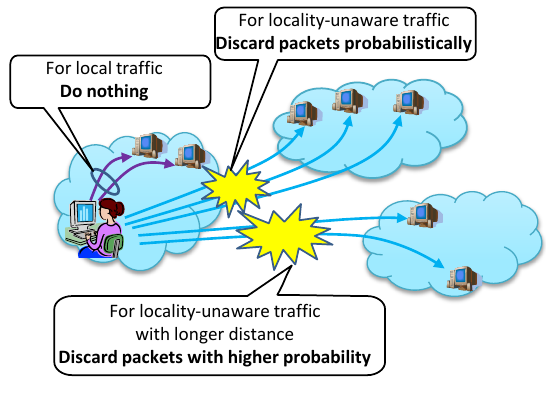
Fig. 1. The concept of PLS.